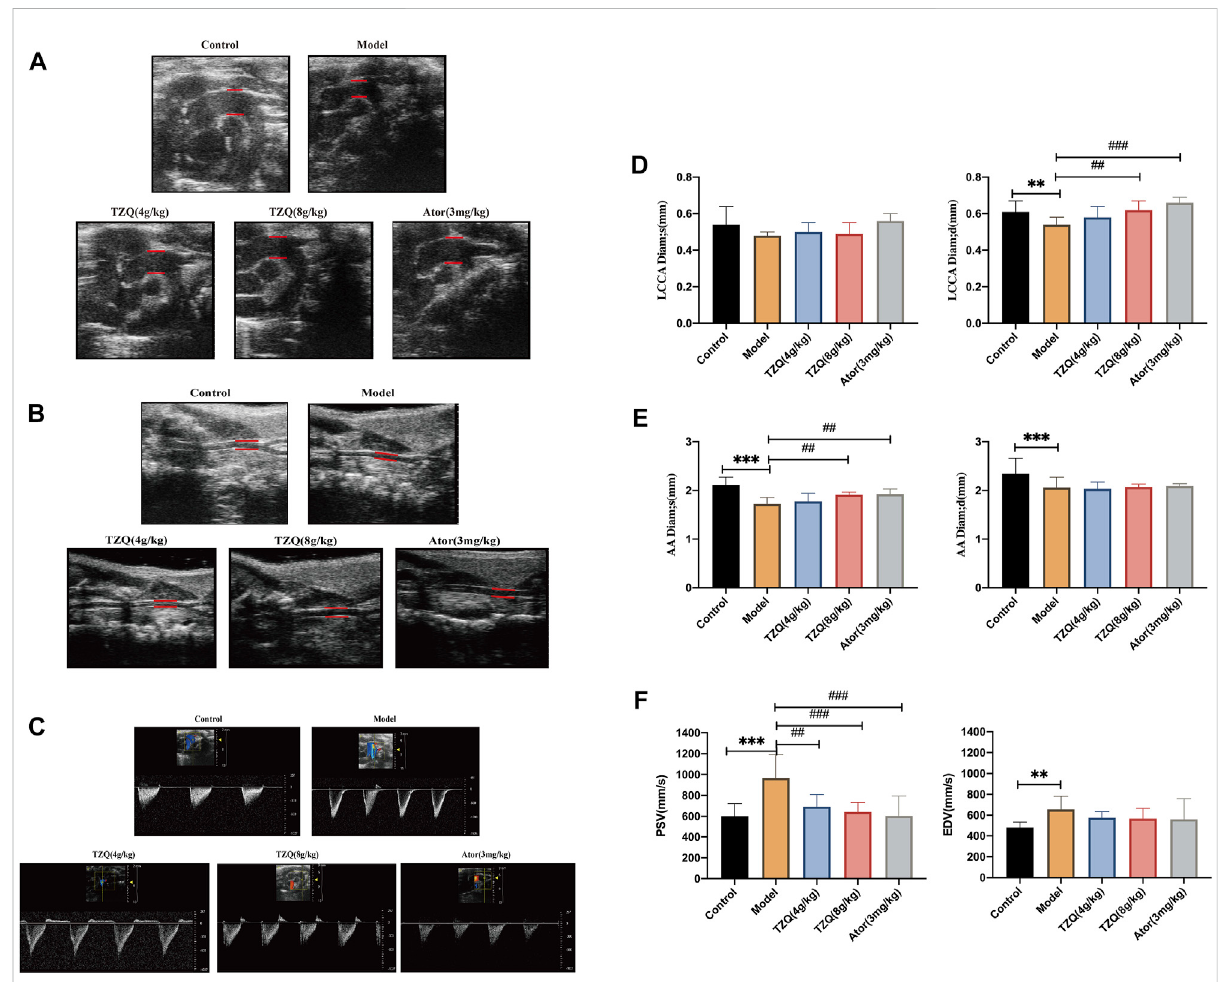
FIGURE 1 Aorticbloodvelocityandlumendiameter ofcommoncarotidartery. (A) :Ultrasound oftheaorticarch. (B) :Carotidarteryultrasound. (C) :Aortic fl ow ultrasonography. (D) : Systolic and diastolic distal diameters of the common carotid artery. (E) : Aortic systolic and diastolic diameters. (F) : Aortic arch blood fl ow velocities systolic and diastolic. LCCA Diam;s: Distal systolic diameter of common carotid artery; LCCA Diam;d: Distal common carotid artery diastolic diameter; AADiam;s: Aortic systolic diameter; AADiam;d: Aortic diastolic diameter; PSV: Aortic arch systolic blood fl